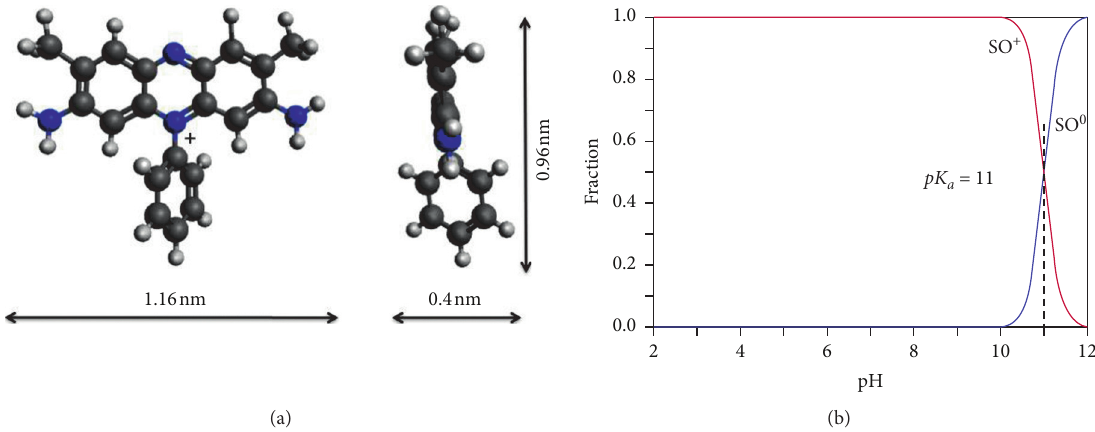
Figure 1: Molecular structure of SO viewed from different directions (a) and its pH speciation